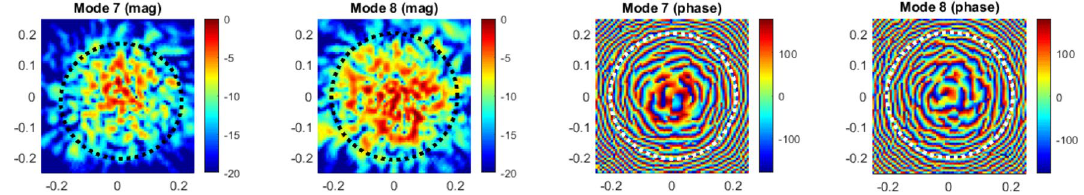
Figure 8. Comparison between magnitude and phase contours of mode 7 and 8.